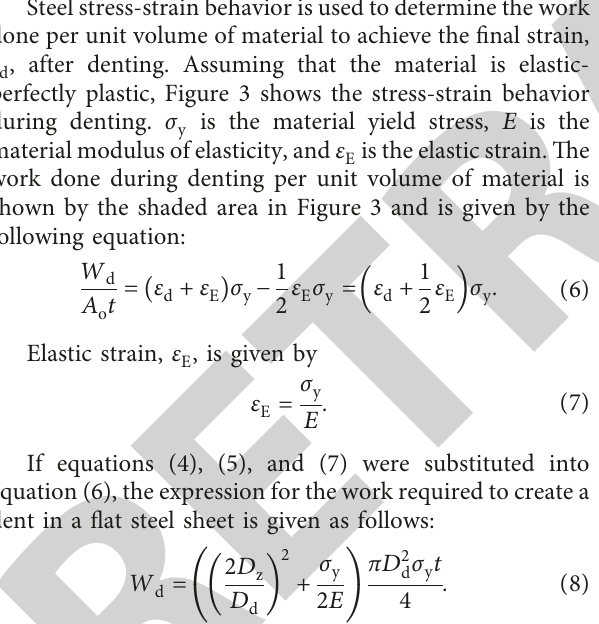
Figure 3: Behavior of stress-strain during